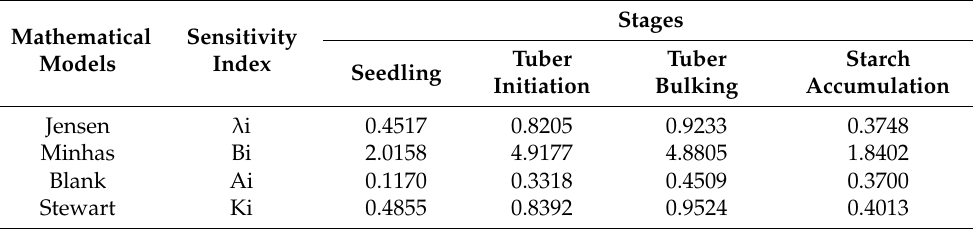
Table 3. Sensitivity indices obtained from the four models for each fertility stage of potato.